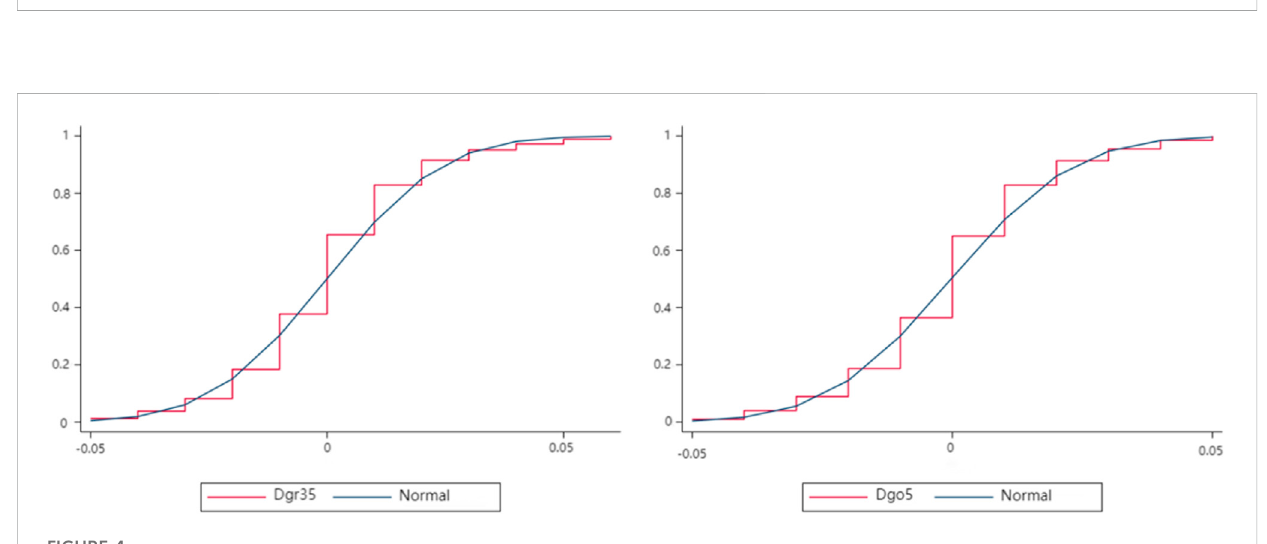
FIGURE 4 The cumulative distributions of Dgr35 and